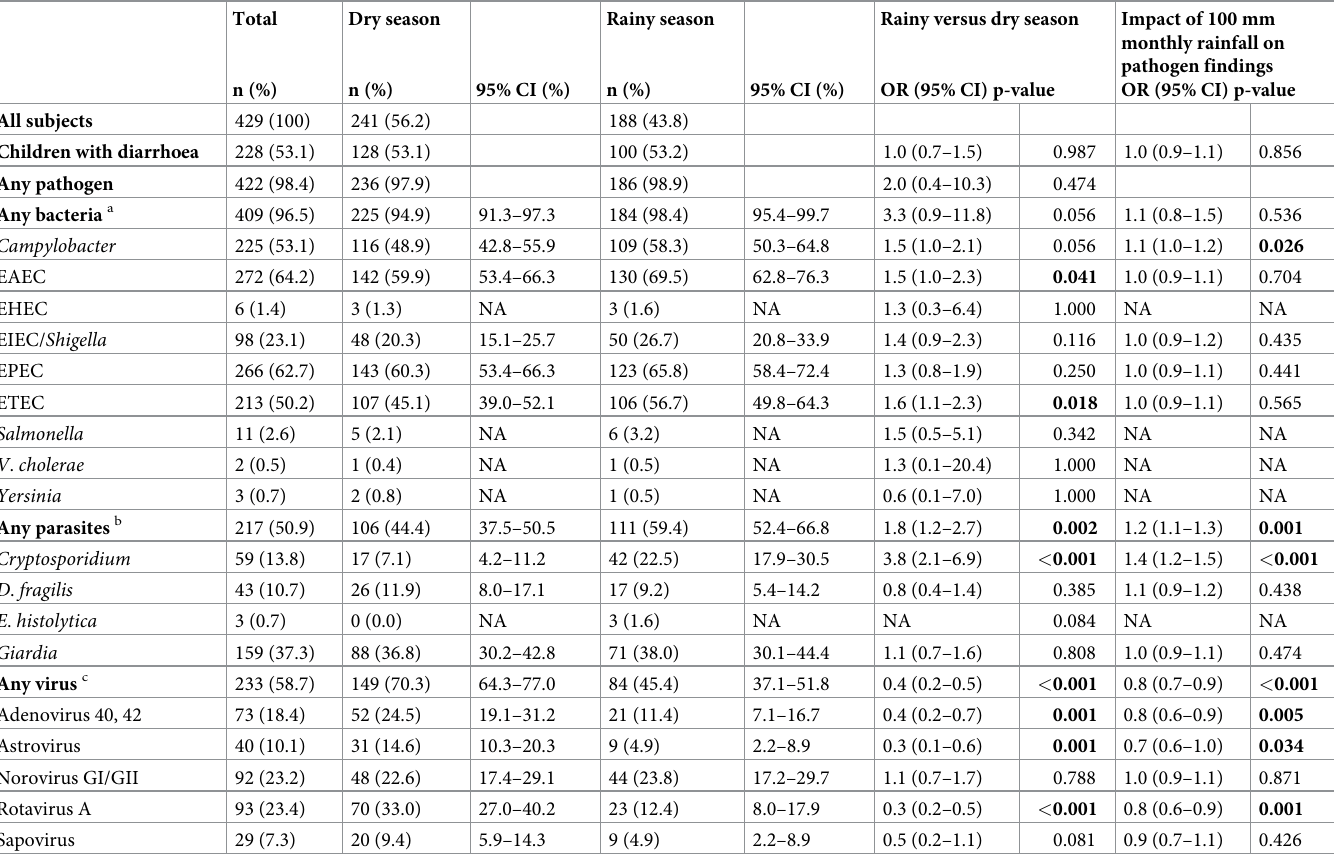
Table 1. Microbial findings among 429 Guinea-Bissauan children under five years of age during dry (November to May) and rainy (June to October) seasons �